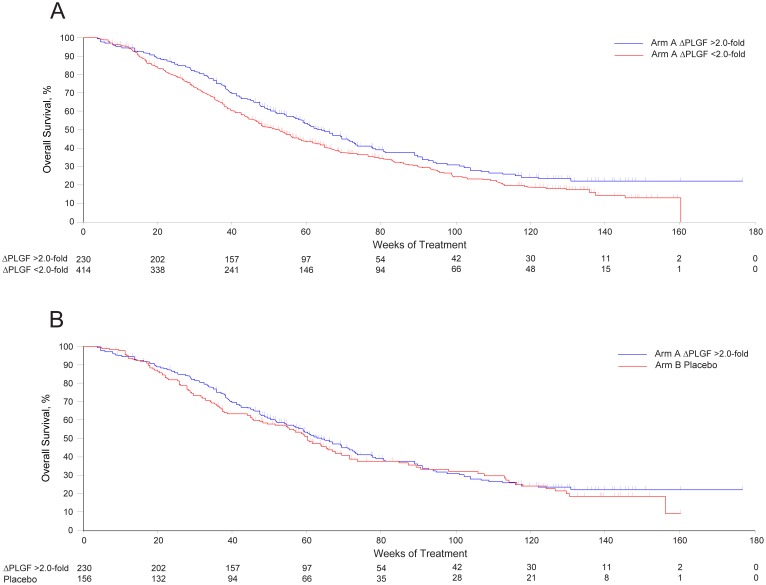
Association of fold-change in placental growth factor (PLGF) and outcomes in the MONET1 study.Overall survival in Arm A among patients with a ≥2.0-fold (blue line) or <2.0-fold (red line) change from baseline in PLGF is shown in (A). Overall survival in Arm A among patients with a ≥2.0-fold change from baseline in PLGF (blue line) compared with placebo (red line; patients with undetermined PLGF status were excluded) is shown in (B).